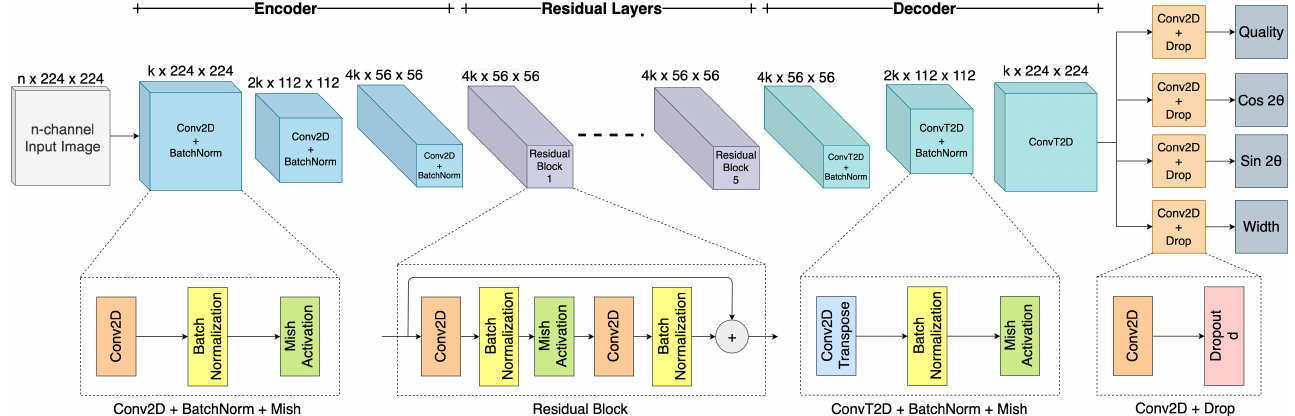
Figure 5. Network architecture of the Generative Residual Convolutional Neural Network v2, where n is the number of input channels, k is the number of filters, and d is the dropout rate. The network takes in an n-channel input image of size 224 × 224 and generates pixel-wise grasps in the form of grasp quality, grasp angle and grasp